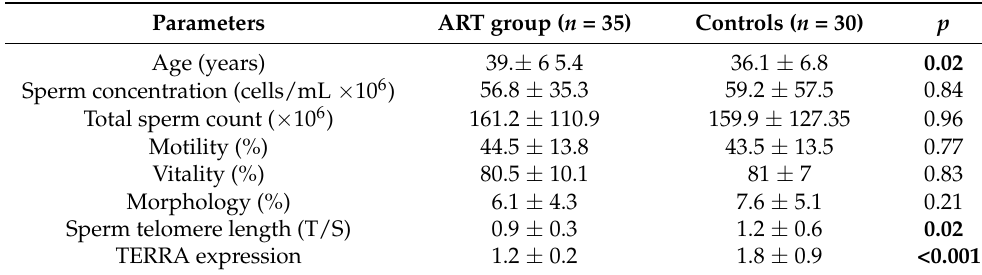
Table 1. Relative telomere length, TERRA and clinical parameters in males who underwent ART and control